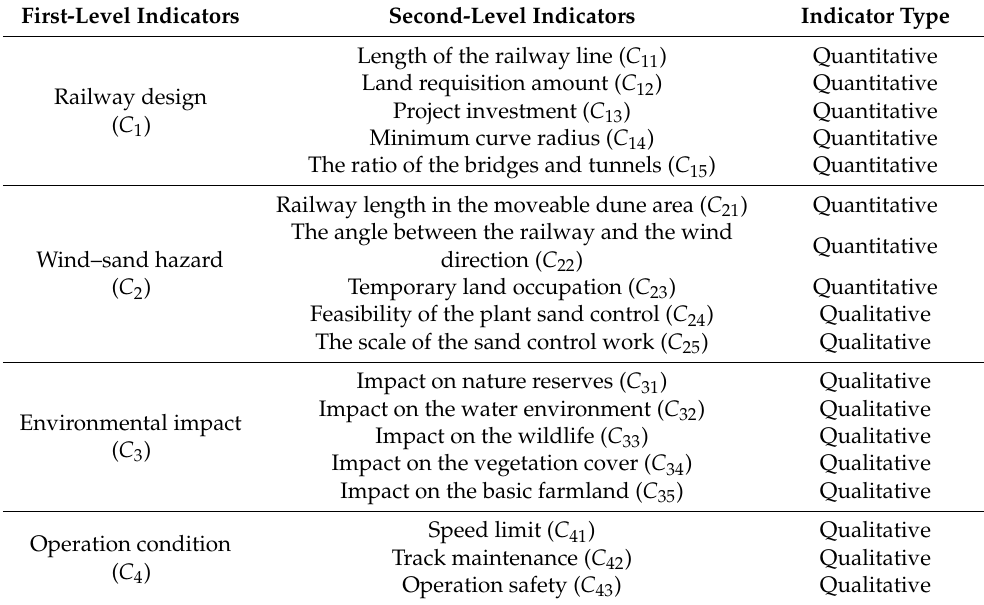
Table 1. Evaluation index system of the desert railway